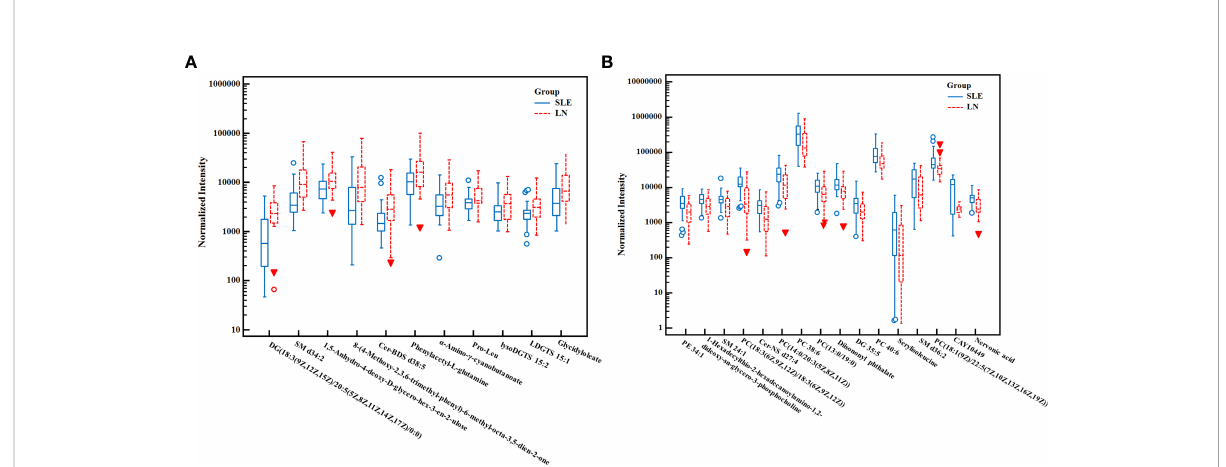
FIGURE 4 The box plot of normalized intensity peak areas of signi fi cantly increased (A) and decreased (B) metabolites in LN group when compared with SLE group. SLE, Systemic lupus erythematosus; LN, Lupus nephritis.